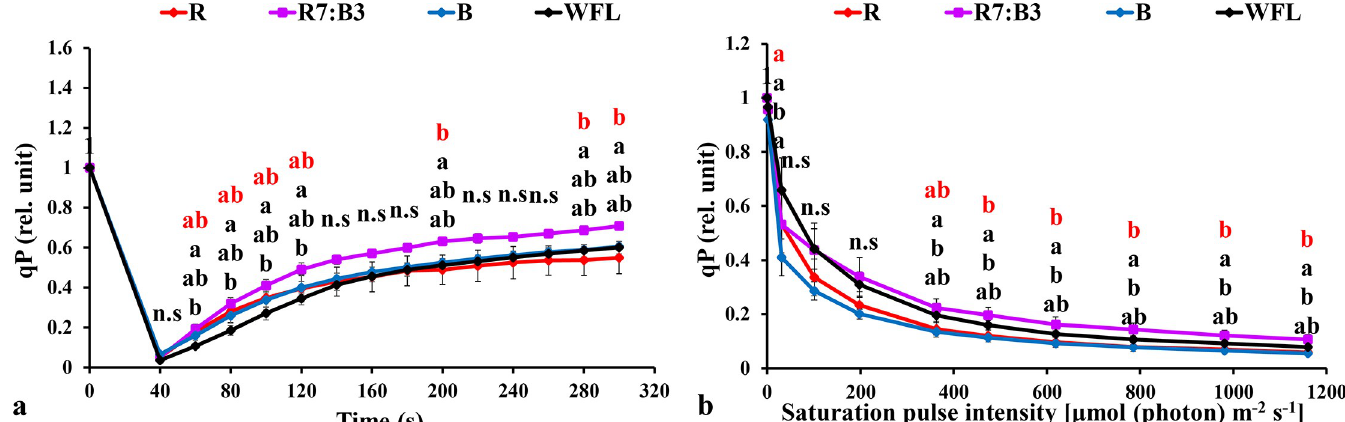
Fig 5. Effect of LED light quality on chlorophyll a fluorescence induction kinetics of dark-acclimated ( a ) and RLC of the light-acclimated ( b ) photochemical quenching coefficient (qP) in grafted tomato leaves. Similar letters indicate a non-significant difference among treatments according to DMRT at P � 0.05. Vertical bars indicate average ± standard error (4 replicates). According to the treatments, sort significance letters from top to bottom (R, R7:B3, B, WFL). Where R = Red light 100%, R7: B3 = Red70%+ Blue30%, B = Blue light 100%, WFL = White Fluorescent Lamps100%.